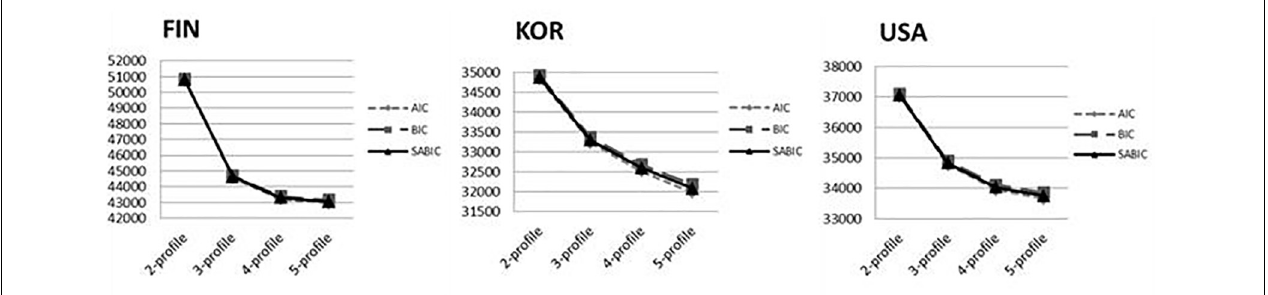
FIGURE 1 | Change patterns for information criteria of different profile solutions across the three samples.